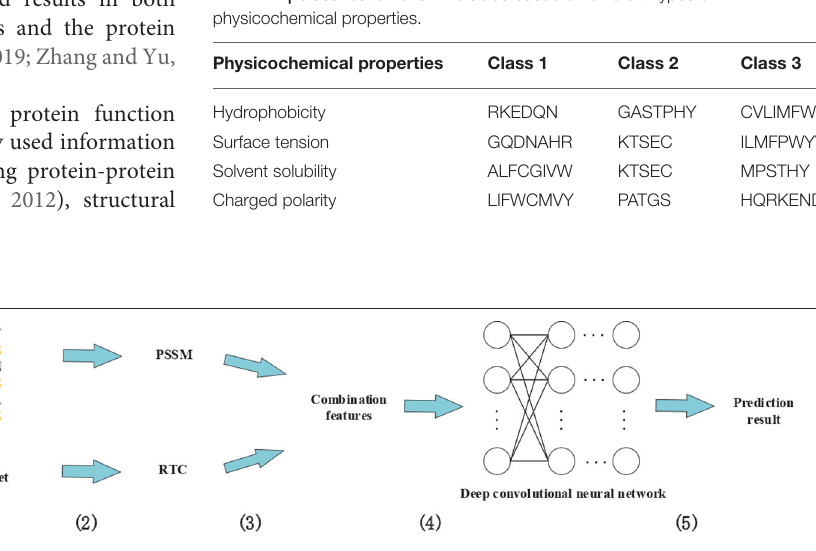
FIGURE 1 | An example using DeepRTCP to predict ABC transporters. (1) Multiple sequence alignments were built for query proteins, and amino acid sequences were replaced with reduced amino acids sequences. (2) The PSSM of the query protein was calculated from multiple sequence alignment, and the RTC was extracted from the reduced amino acids sequence. (3) PSSM and RTC combine into RTCP. (4) Deep convolutional neural network uses RTCP as input to train the classifier. (5) The output of the convolutional neural network passes through a binary classifier to get the prediction result.